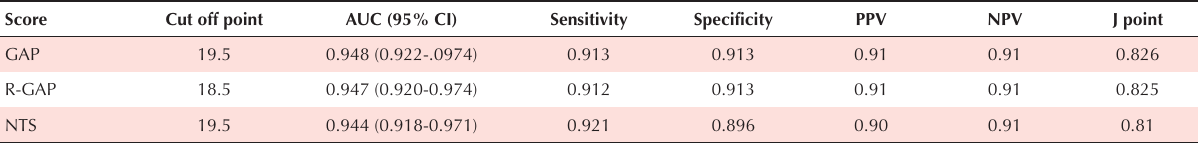
Table 4. Predictive value of GAP, R-GAP, and NTS trauma scores in hospital survival of patients using ROC curve Score